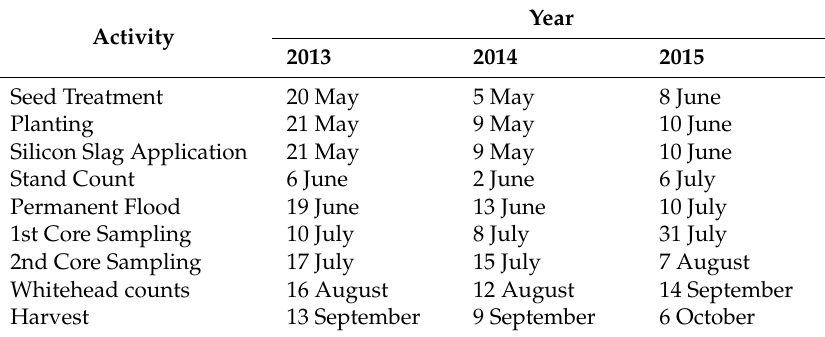
Table 2. Field activities and corresponding